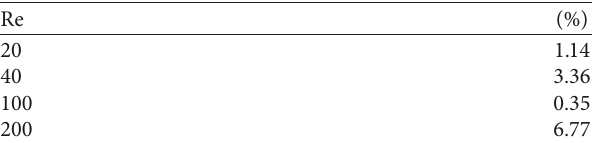
Table 1: Relative errors of different Reynolds